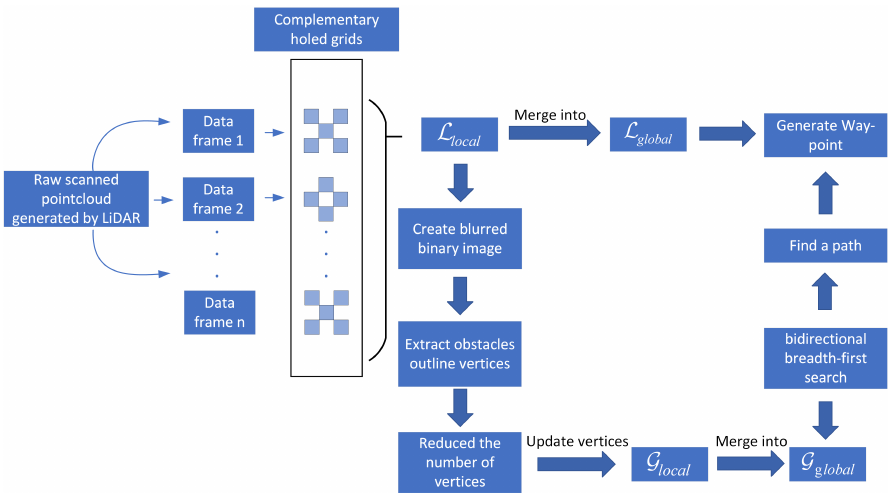
Figure 2. The main flow chart of the path planner based on the